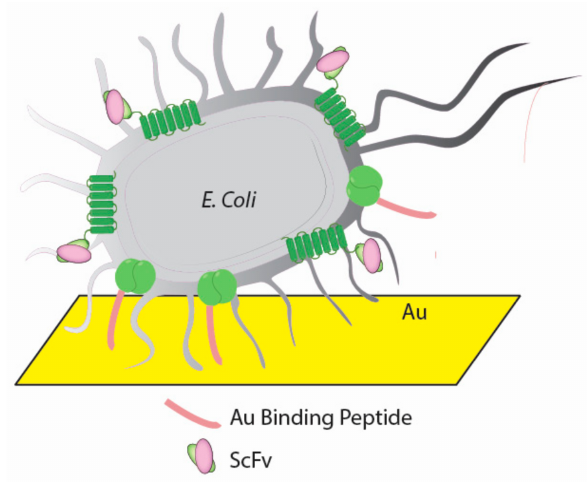
Figure 5. ScFv and gold-binding peptide dual-expression system in E. coli